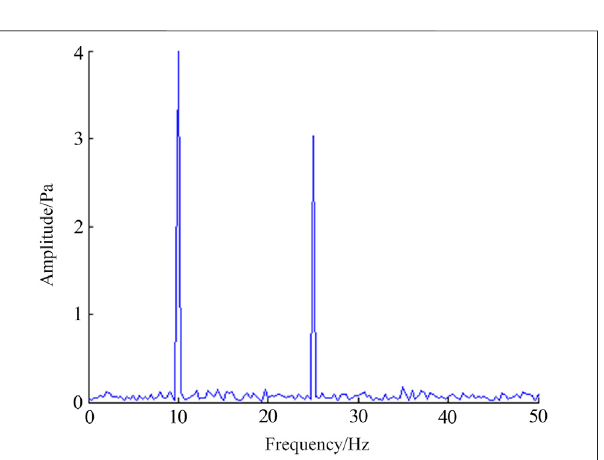
Figure 13 . The spectrum of the denoised signal is shown in Figure 14 .